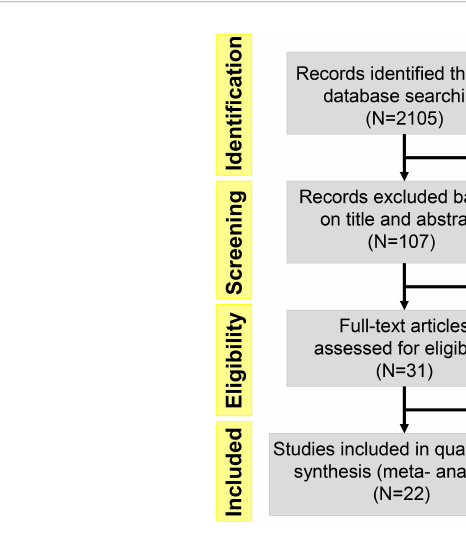
FIGURE 1 Flow diagram of the literature search and trial selection process (N = number of published papers at each